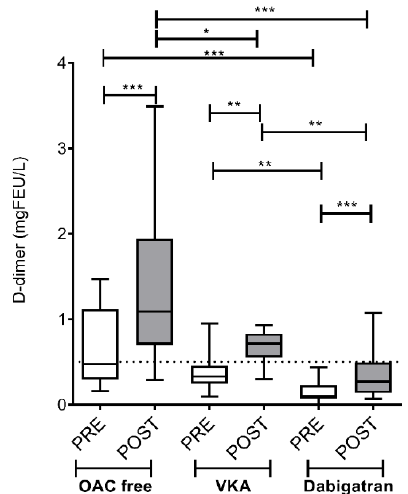
Figure 2. Left atrium D-dimer levels before and after cryoballoon ablation procedure in AF patients on various pre-procedural anticoagulation strategies. Box and whisker plots indicate median, interquartile range, and total range. Dashed lines indicate diagnostic cut-off level for venous thromboembolic events (0.5 mg/L). PRE (empty bars): pre-ablation, POST (solid bars): post-ablation, OAC: oral anticoagulant, VKA: vitamin K antagonist. * p < 0.05, ** p < 0.01, *** p < 0.001. Statistical significance remained essentially the same when assessed after controlling for the effect of covariates associated with selection (age, sex) between treatment groups.